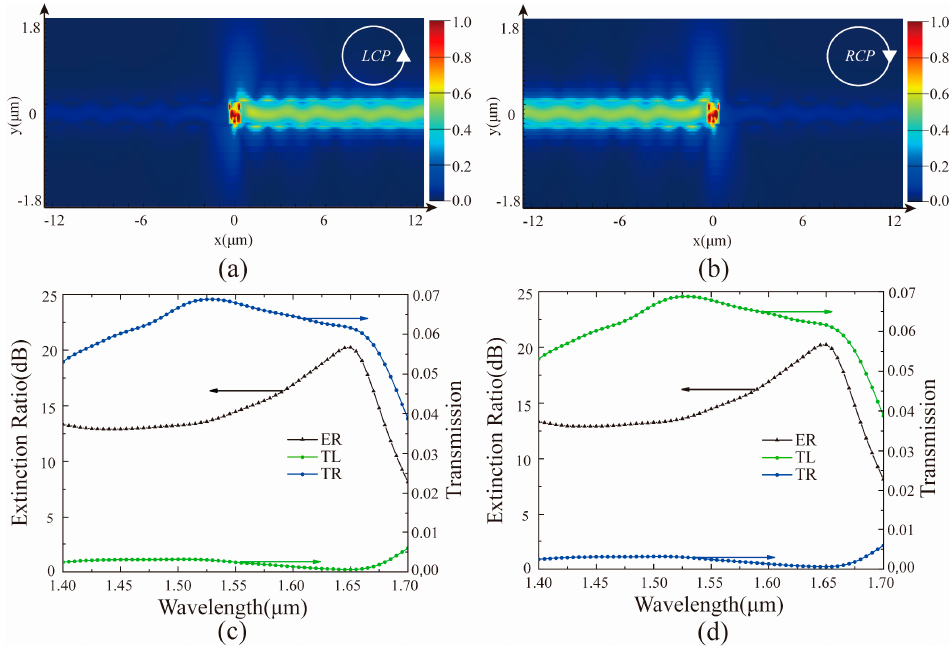
Figure 2. The electric field distribution with a wavelength of 1650 nm under the illumination of ( a ) left-handed circularly polarized light (LCP) and ( b ) right-handed circularly polarized light (RCP) light, respectively. The power transmittance of the two monitors (ML and MR) under the incidence of ( c ) LCP and ( d ) RCP light, respectively. TL represents the transmittance measured by the power monitor ML, and TR represents the transmittance measured by the power monitor MR.